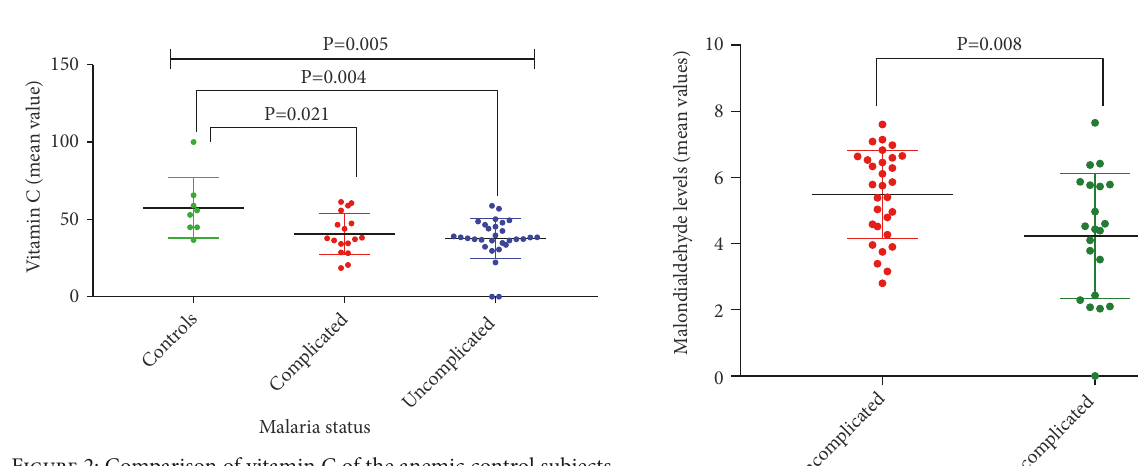
Figure 2: Comparison of vitamin C of the anemic control subjects and anemic uncomplicated and complicated malaria subjects.